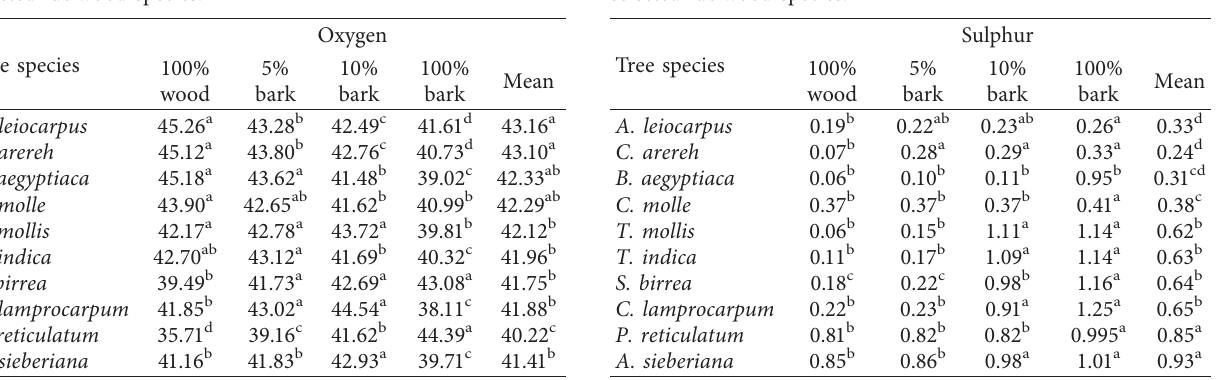
Table 4: Effect of bark inclusion on the sulphur content (%) of the selected fuelwood species.